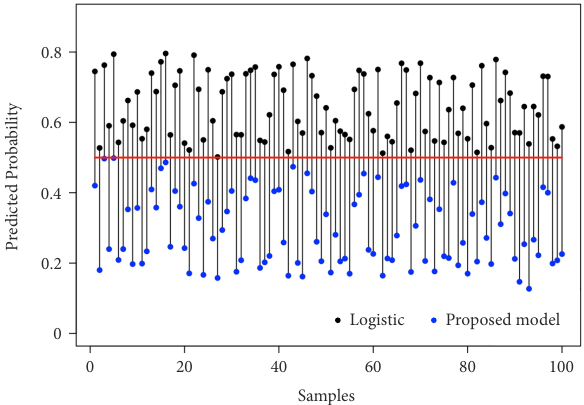
Figure 10. Some examples of the prediction probabilities for the two models